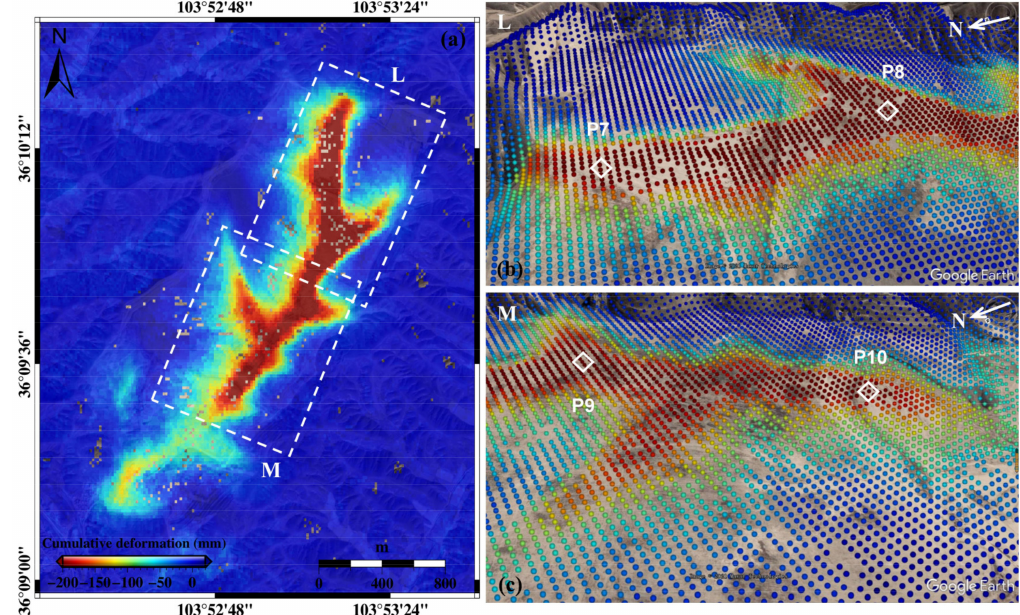
Figure 22. ( a ) Cumulative displacement map of Region F between December 2015 and March 2021. The location of Region F is marked in Figure 11. Regions L and M marked by white dashed rectangles are the two deforming areas with larger cumulative displacement, and their enlarged displacement maps are presented in ( b , c ),